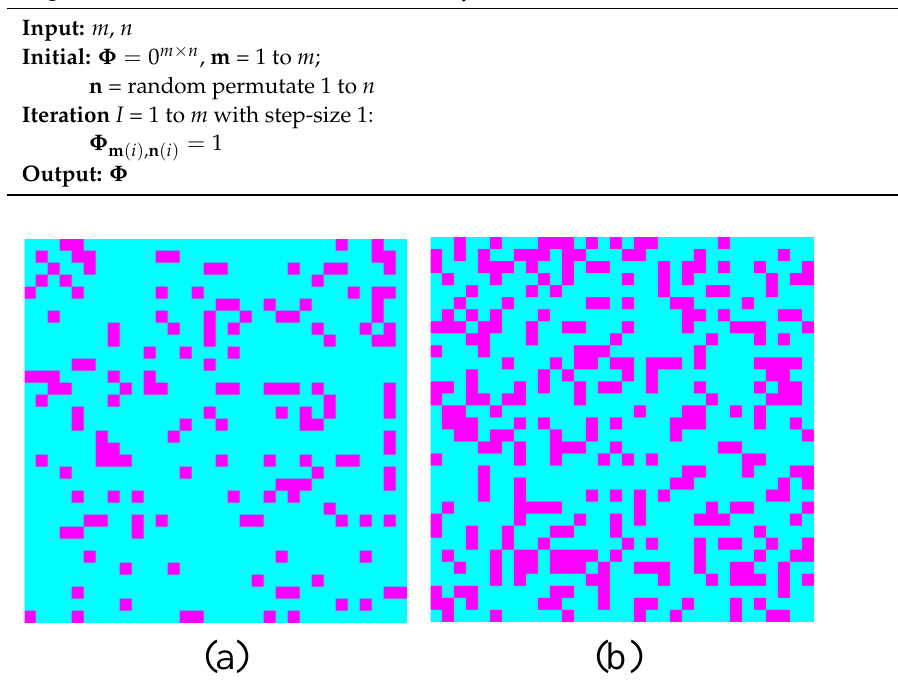
Figure 4. Demo sampling locations (The red dots) on a 32 × 32 area with sampling rates of ( a ) 15% and ( b ) 30% by the designed Φ .